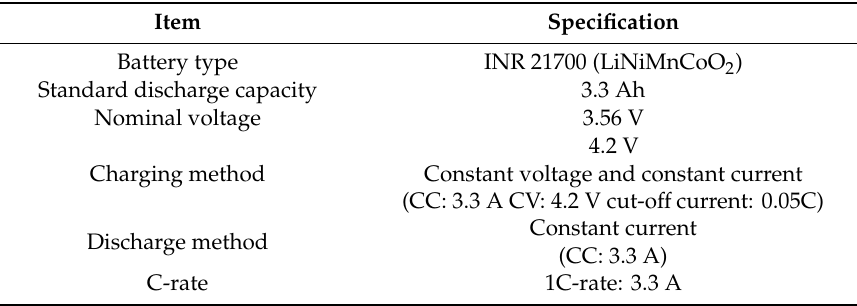
Figure 1. Experimental platform of the battery. Table 1. Battery specification .